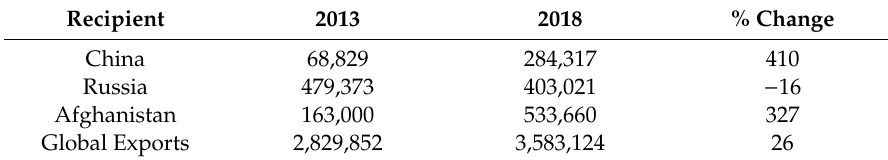
Table 7. Central Asian agricultural exports (in USD, multiply by 1000) *, 2013–2018